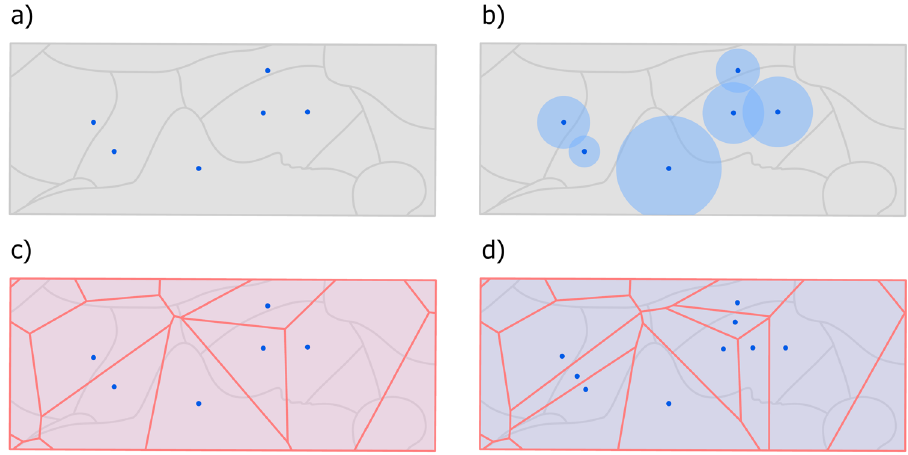
Fig. 3 Four methods of distributing CDR data into administrative units. a Point to Polygon, b Tower ranges, c Voronois, d Adjusted Voronois. Note: This fi gure was created using entirely fi ctitious data points, ranges and unit